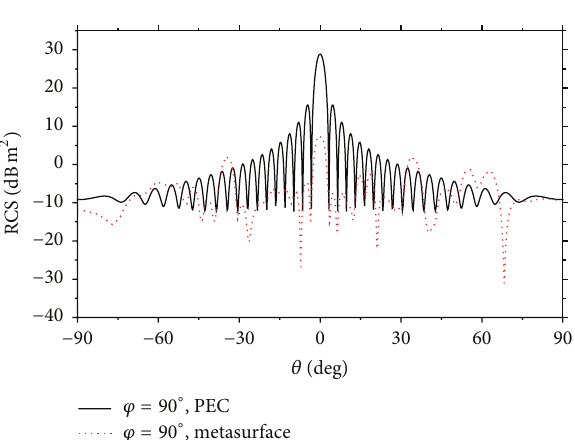
Figure 15: Comparison of the bistatic RCS at 17GHz along 𝑦𝑜𝑧 plane for the metasurface and the PEC plate.